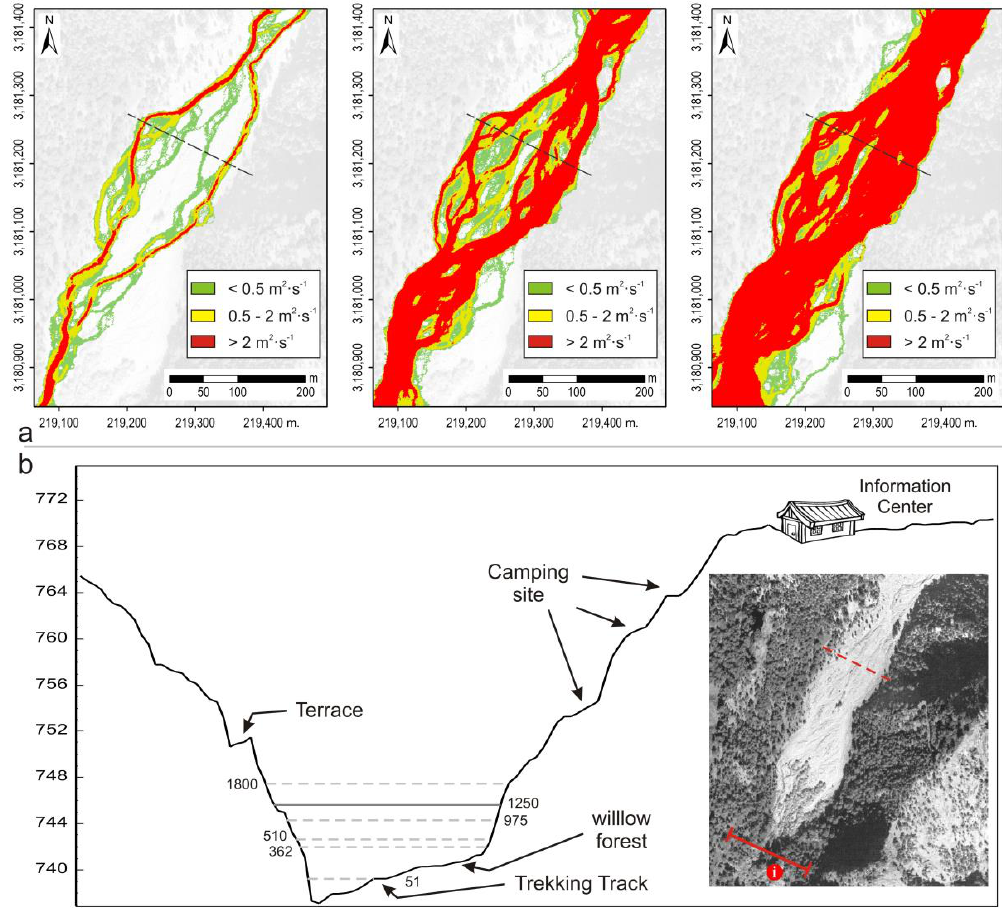
Figure 9. ( a ) Flood risk maps showing where people may suffer loss of stability due to flow ( left : 50 m 3 s − 1 ; center : 510 m 3 s − 1 ; right : 1250 m 3 s − 1 ); and, ( b ) Flow — flood stage graph near the Caldera de Taburiente National Park Information Center. Solid red line shows location of the cross section associated with flood stage values, and Caldera de Taburiente National Park Information Center. Dashed red line shows channel cross section used in Figures 7 and 8.